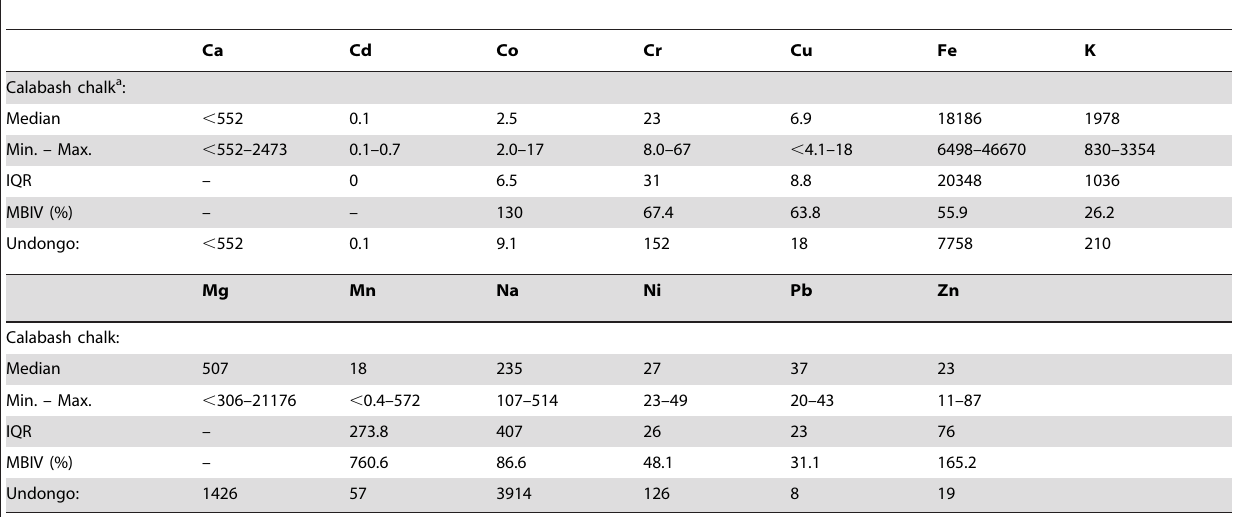
Table 4. Descriptive statistics summarising the pseudo-total content (mg/kg) of the Calabash chalk samples, and concentrations determined from the Undongo